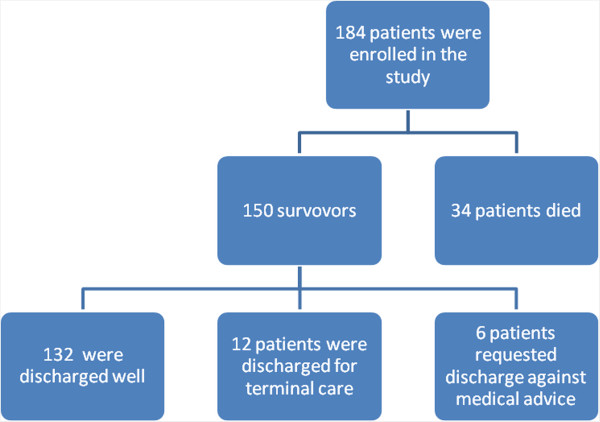
Distribution of patients according to follow up of patients.